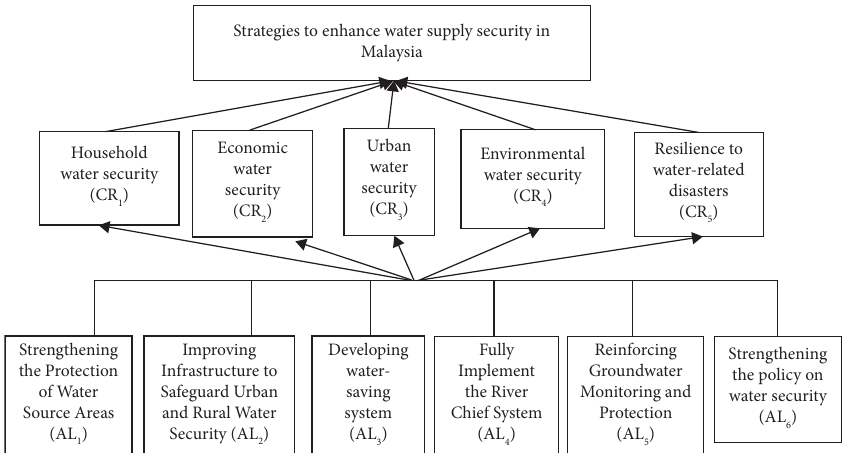
Figure 5: Hierarchy structure of the most suitable alternative for water security. Table 3: Te rating of each alternative under each